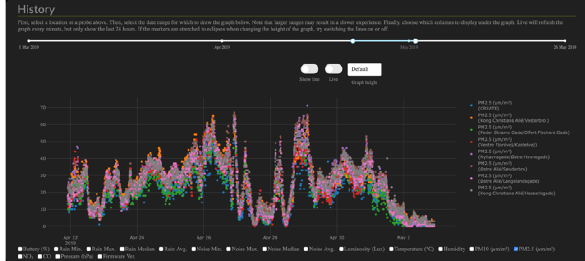
Figure 5. Example scatter diagram from the CityProbe dashboard shows PM2.5 data from 8 stations for 1 week.